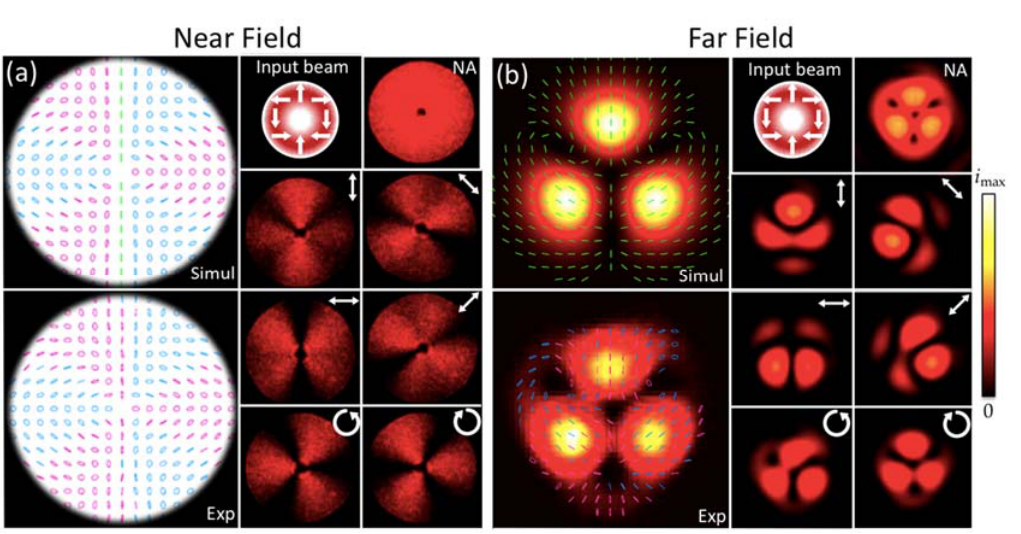
Figure 6. Results for a QW q-plate illuminated with a radially polarized beam of order (cid:96) = 2. ( a ) Results in the near field; ( b ) results in the far field. Simulated and experimental polarization maps, with equivalent color representation as in Figure 3. Experimental images captured for different orientations of the analyzer, indicated as white arrows (NA indicates no analyzer).